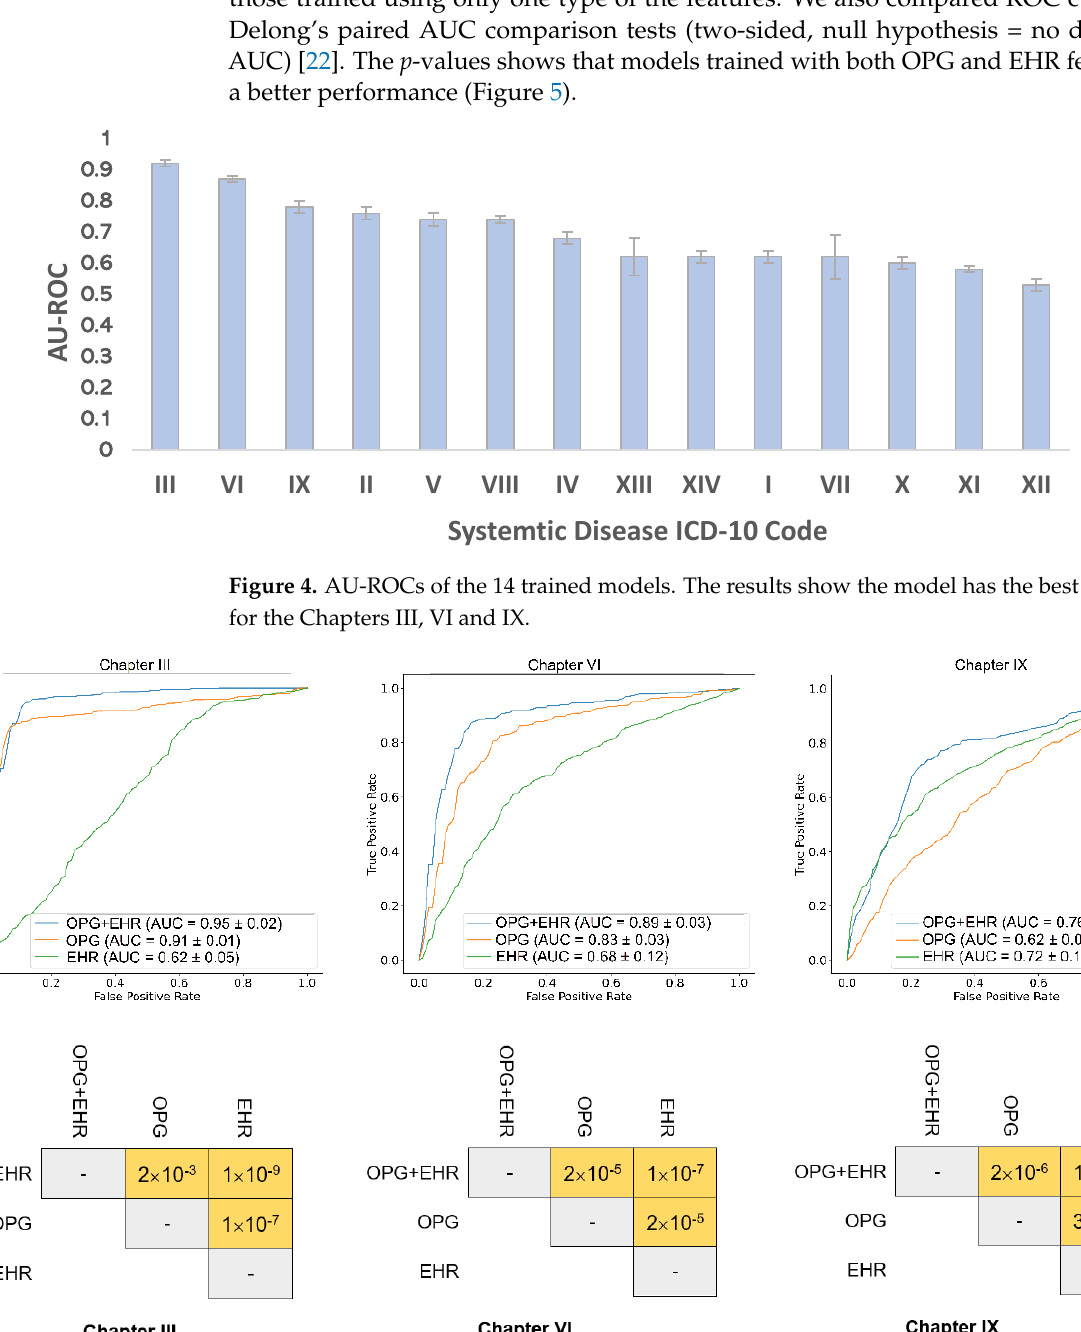
Figure 5. Ten-fold cross validation results for the training datasets (top row) and AUC comparison of the models using Delong test (bottom row). The model was trained with three different sets of features. Fused features of the OPG and clinical information showed the best performance.